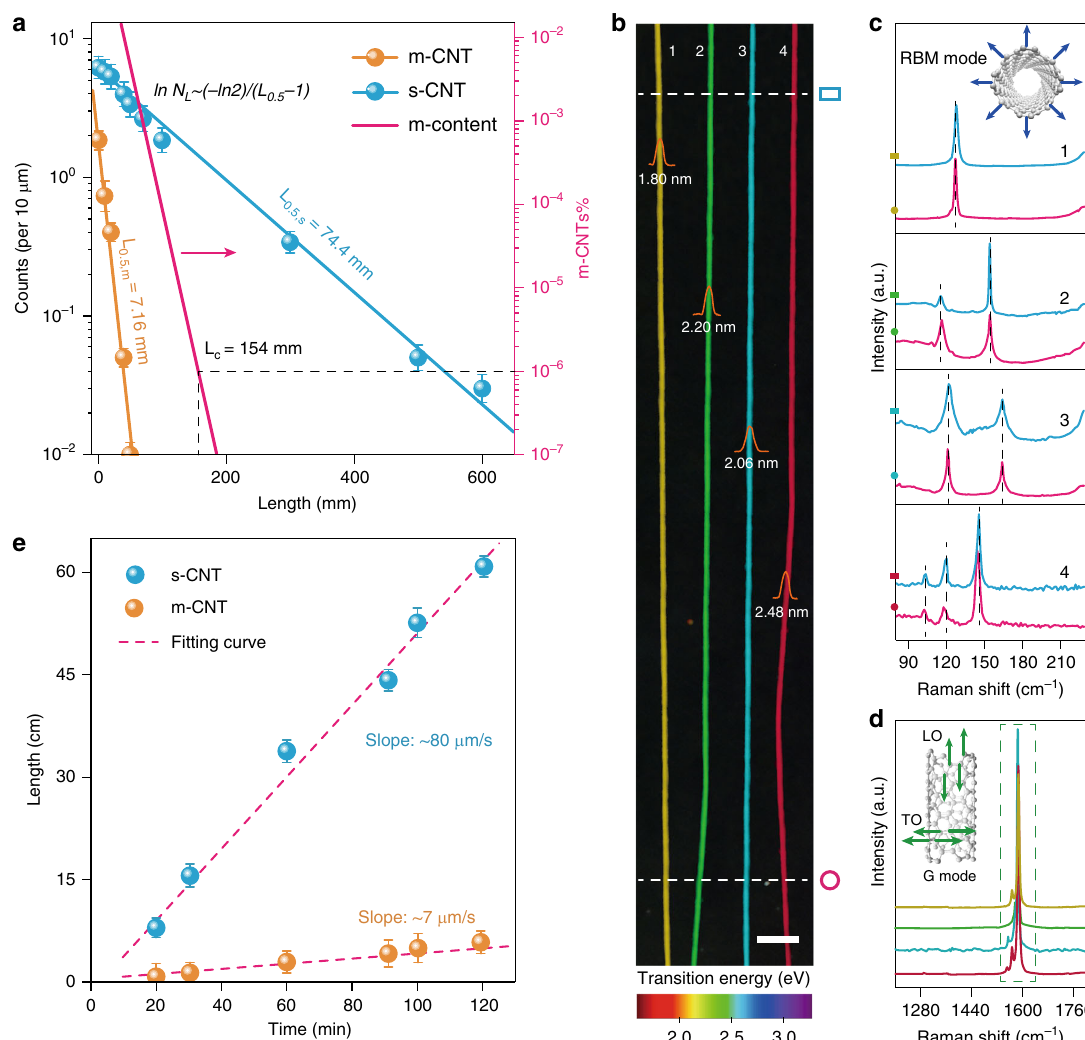
Fig. 1 Growth behavior analysis of m- and s-CNTs. a Quantity statistics of m- and s-CNTs at the same length, by summing up all four samples (~710 CNTs). The m-percentage line is derived from the number of total CNTs divided by that of m-CNTs. b Spatial Rayleigh images of representative ultralong CNTs spliced onto the same background. Their respective height traces measured with the atomic force microscope (AFM) are shown inset. Scale bar, 10 μ m. c RBM modes of the top and bottom parts probed from each tube in b . d G mode waterfall of the corresponding ultralong CNTs. e Growth rates of m- and s-CNTs on array scales. Error bars represent the standard deviation of n = 10 longest m- or s-tubes grown at varied growth